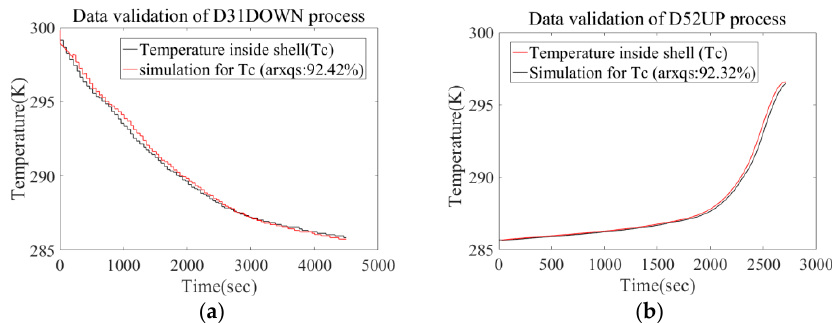
Figure 6. Comparison between real measurement and prediction data group ( T c - T s ). ( a ) Comparison for diving profile process of #31 ROV task. ( b ) Comparison for floating profile process of #52 ROV task.